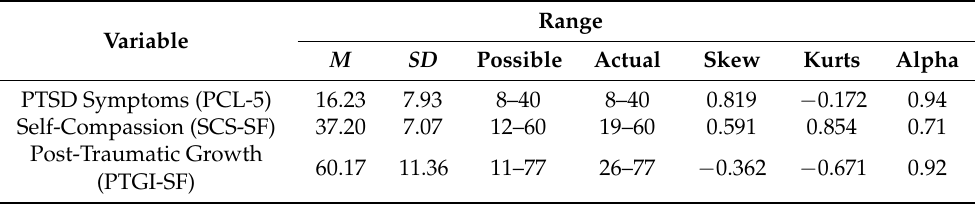
Table 1. Descriptive statistics of study variables: PTSD symptoms, self-compassion, and PTG.